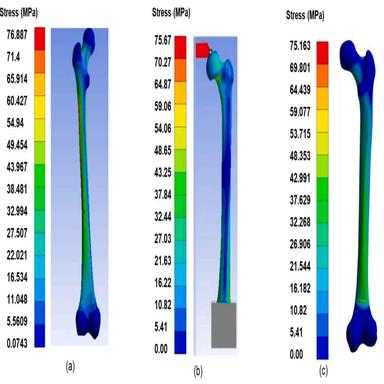
Validation of the femur model with the previous literature. The equivalent stress distribution in the femur bone by Das et al. (2014), (b) Ebrahimi et al. (2012), and (c) present FE model.